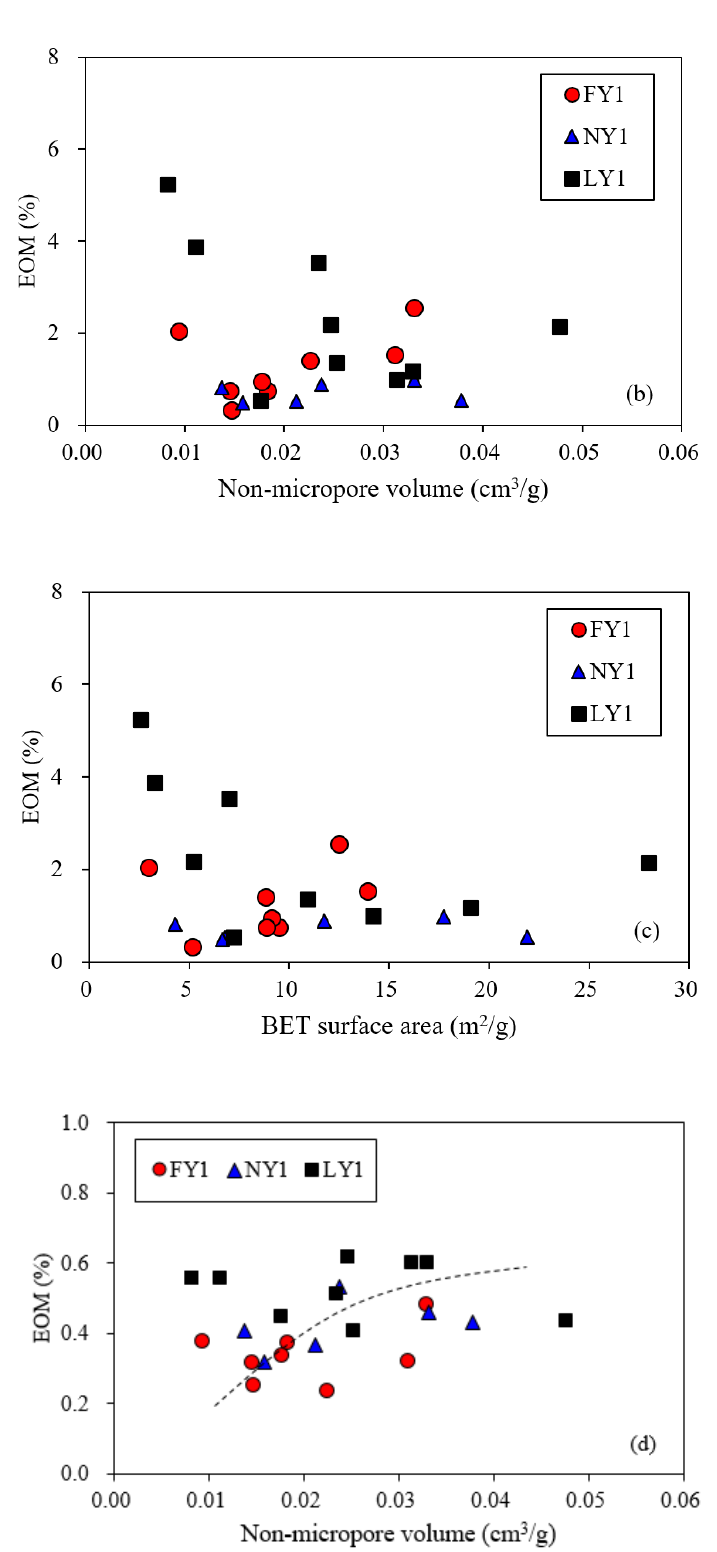
Figure 15. Plots shows relationships of pore structure parameters with EOM ( a – c ) and EOM/TOC ( d ) for the studied samples.